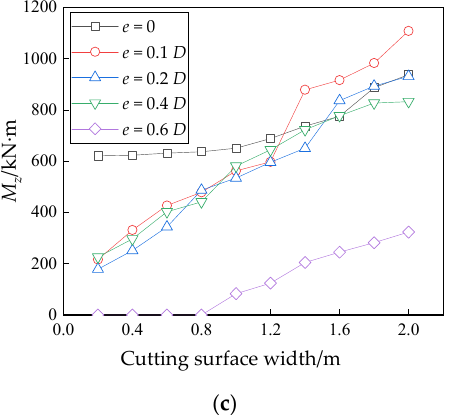
Figure 17. Effect of the cutting surface width B on the interaction moment: ( a ) M x ; ( b ) M y and ( c ) M z .